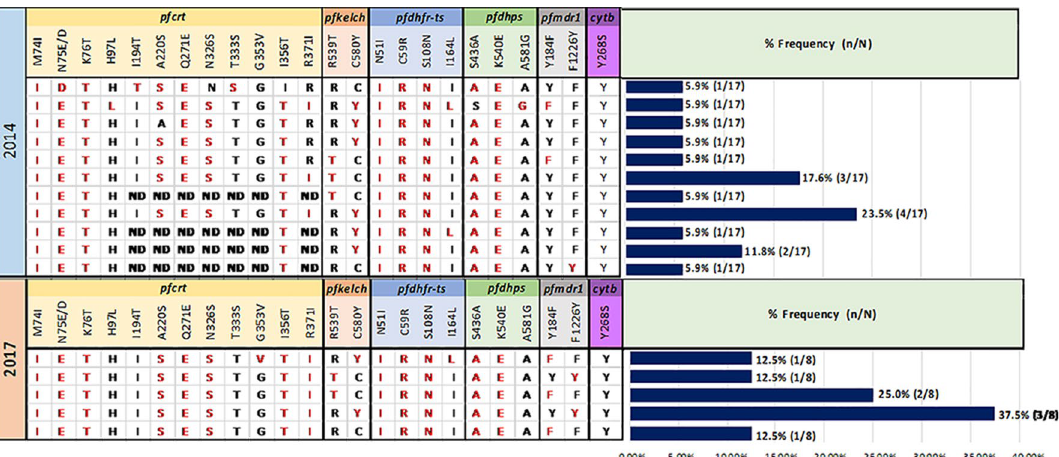
Figure 5. Bar chart represents the genetic patterns which were observed in six drug resistance genes in Ubon Ratchathani province in 2014 and 2017. The results of the two TADs protocols are not different from conventional Sanger sequencing. In the Ubon0029 isolate, pfdhfr gene at position I164L was detected as a mixed allele by two TADs protocols, but conventional Sanger sequencing called it a homozygous